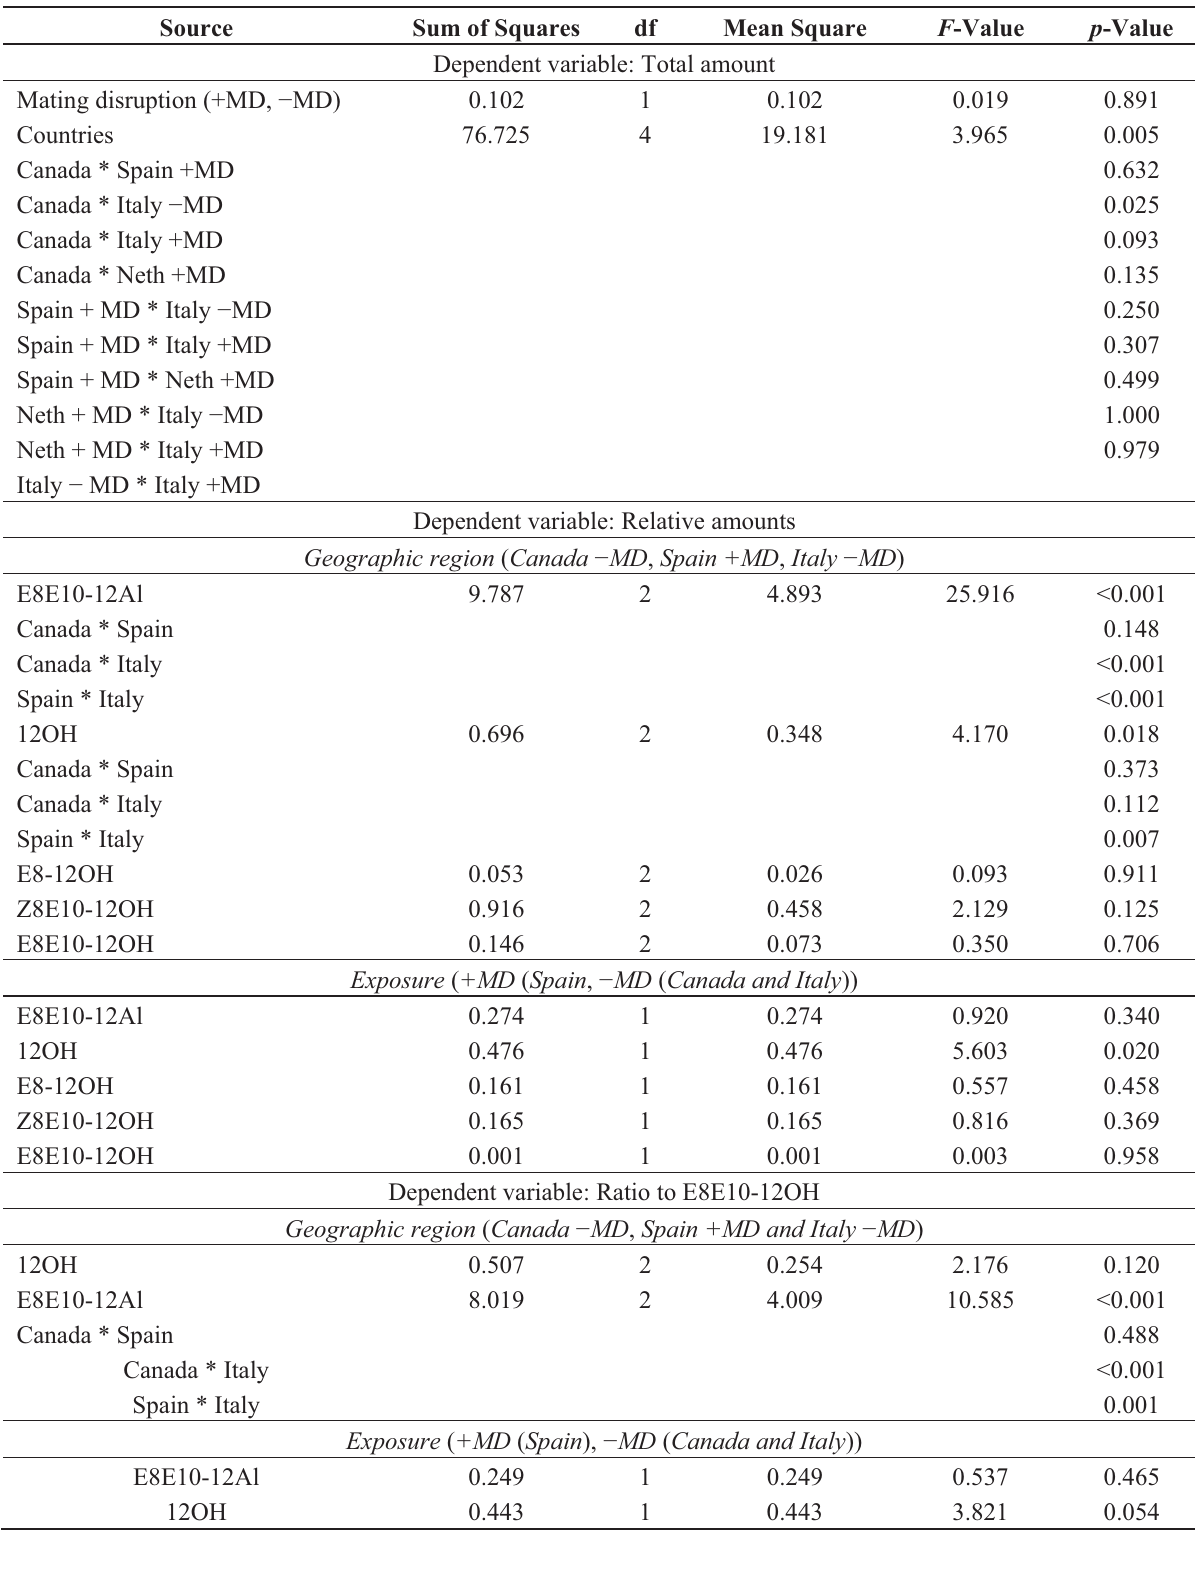
Table 2. Statistical analysis to compare the sex pheromone amount and composition of Cydia pomonella females from different geographic origin, exposed or not to mating